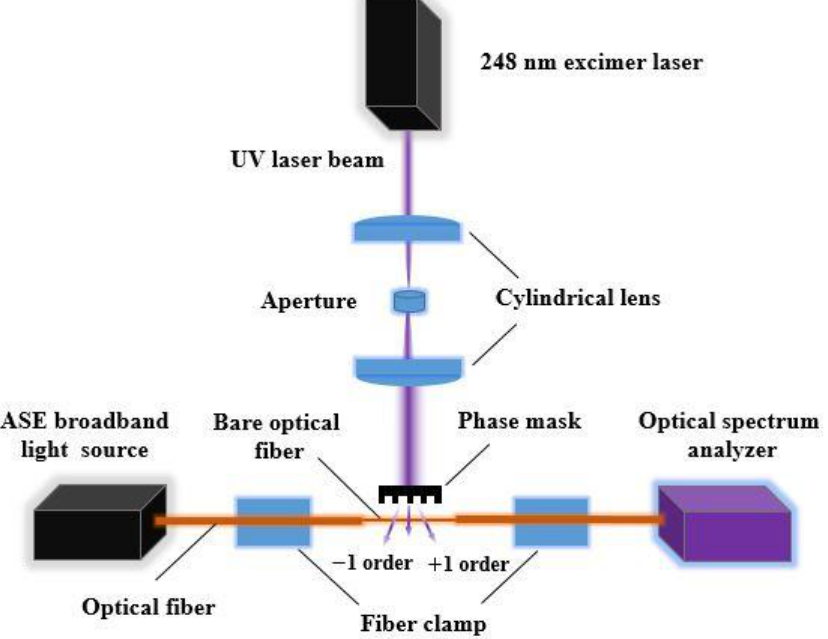
Figure 2. Schematic diagram of the experimental setup for fabricating the uncoated FBG sensors using UV laser based phase mask technology.